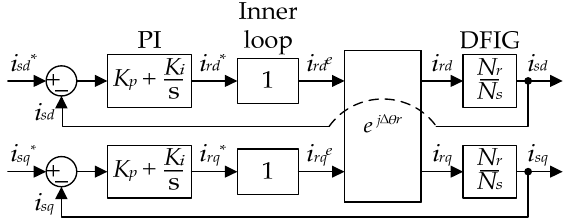
z s s Figure 6. Bode diagram of the open ‐ loop transfer function of the proposed decoupled control. The controller design and the transient response of the proposed decoupled control are dependent on the stator ‐ to ‐ rotor turns ratio, which is slightly affected by saturation and can be considered constant up to about 120% of the rated stator flux [34] which is normally the case. Thus, the proposed decoupled control can be considered independent of variations in the DFIG parameters. 3.3. Sensitivity to Slip Angle Inaccuracy The measurement or the estimation of the DFIG’s rotor position, which is used to obtain the slip angle, will always contain a certain amount of error especially in the case of software estimators due to inaccuracy in their mathematical model. Thus, it is important to investigate the effect of inaccuracy in the slip angle on the performance of the proposed decoupled control. In the decoupled control, the slip angle is used to express the rotor quantities in the dq ‐ frame. Let’s assume that this slip angle, which is referred to as θ re , contains an error Δθ r as in:      e r r r (12) The dq ‐ transformation of the rotor current using θ re , which is referred to as i re , is related to the correct dq ‐ transformation of the rotor current by: